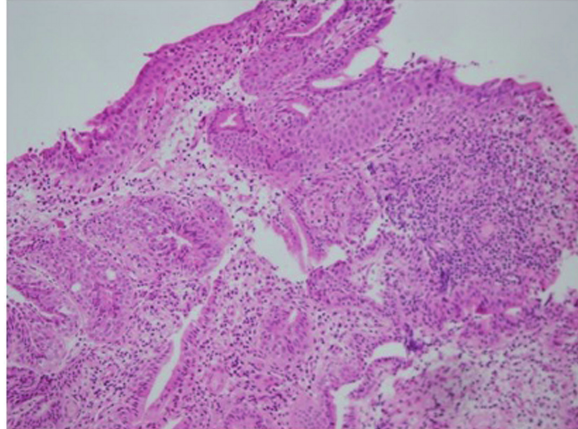
figure 2 - focal intestinal metaplasia (h-E staining, 200